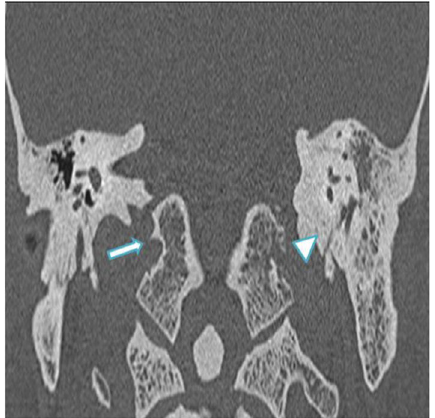
Fig. 10 Coronal HRCT temporal bone image of a 59-year-old male patient with invasive oto-mastoiditis and resultant skull base osteomyelitis showing erosions of left hypoglossal canal and jugular tubercle (arrow head). Right hypoglossal canal and jugular tubercle is normal (arrow)